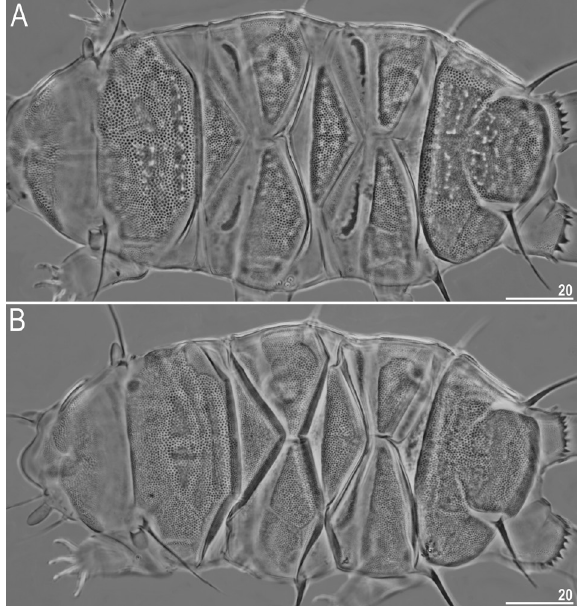
Figure 3. Close-up on the details of sculpturing of E. masculi- nus sp. nov. (PCM). A. evident epicuticular layer, endocuticu- lar pillars of various sizes; B. remnants of epicuticular layer on the scapular and caudal (terminal) plates, endocuticular pillars densely packed and of equal, minute size. All scale bars in